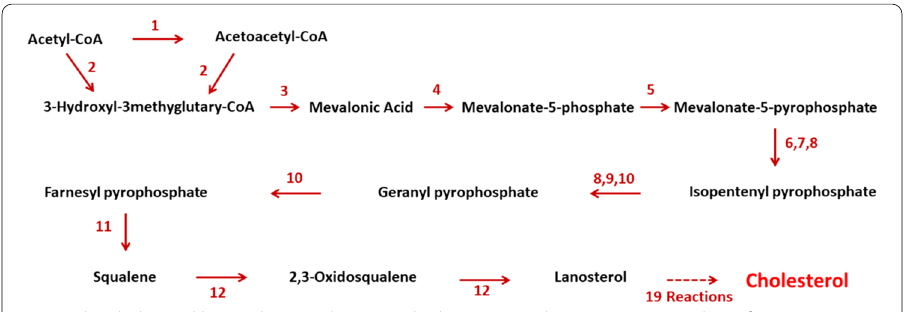
Fig. 2 The cholesterol biosynthesis pathway. (1) Thiolases or acetyl-coenzyme A acetyltransferases, (2) hydroxy-3-methylglutaryl-CoA synthase, (3) hydroxy-3-methylglutaryl-CoA reductase, (4) mevalonate-3-kinase or me- valonate-5-kinase, (5) mevalonate-3-phosphate-5-kinase or phosphomevalonate kinase, (6) mevalonate-5-phosphate decarboxylase, (7) mevalonate pyrophosphate decarboxylase, (8) isopentenyl phosphate kinase, (9) isopentenyl pyrophosphate isomerase, (10) farnesyl-diphosphate synthase, (11) squalene synthase, or FDFT1, (12) squalene monooxygenase or squalene epoxidase. There are 19 reactions, including multiple demethylations, desaturations, isomerizations, and reductions